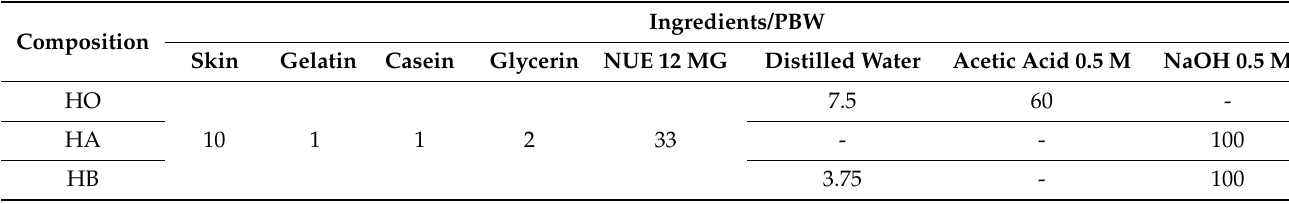
Table 10. Compositions of the matrixes in PBW.